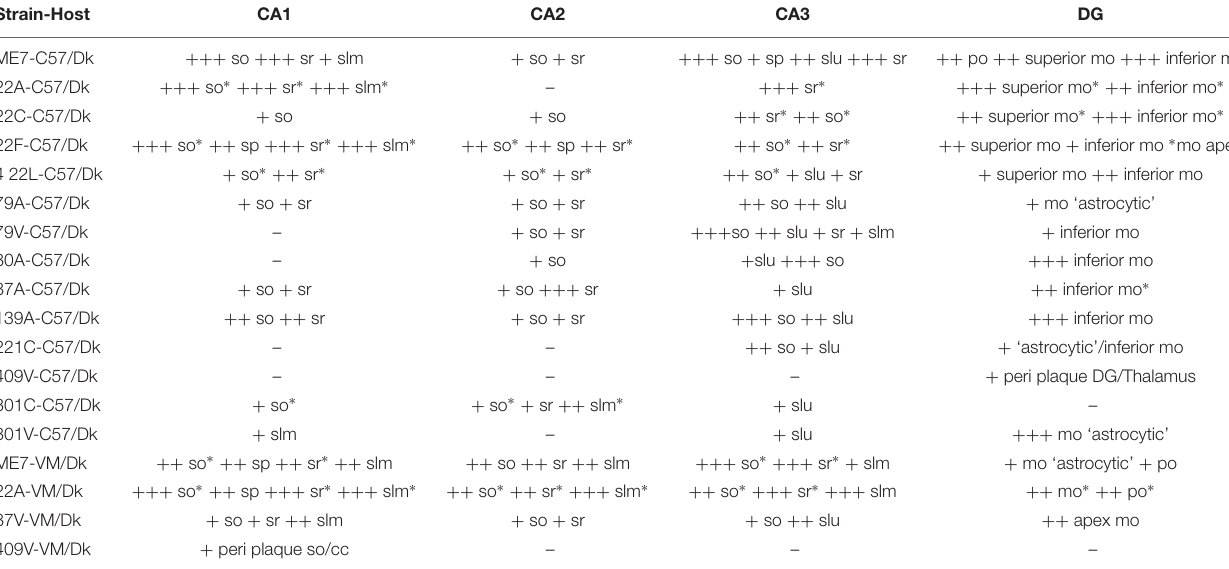
TABLE 2 | Prion agent strain typing based on hippocampal CD44 expression pattern. Strain-Host CA1 CA2 CA3